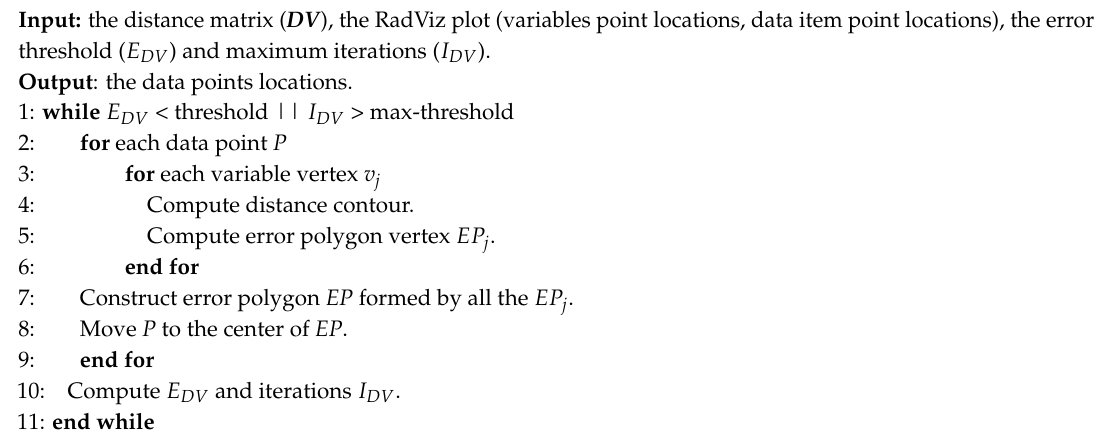
Algorithm 2. Iterative Data to Attribute Layout Error